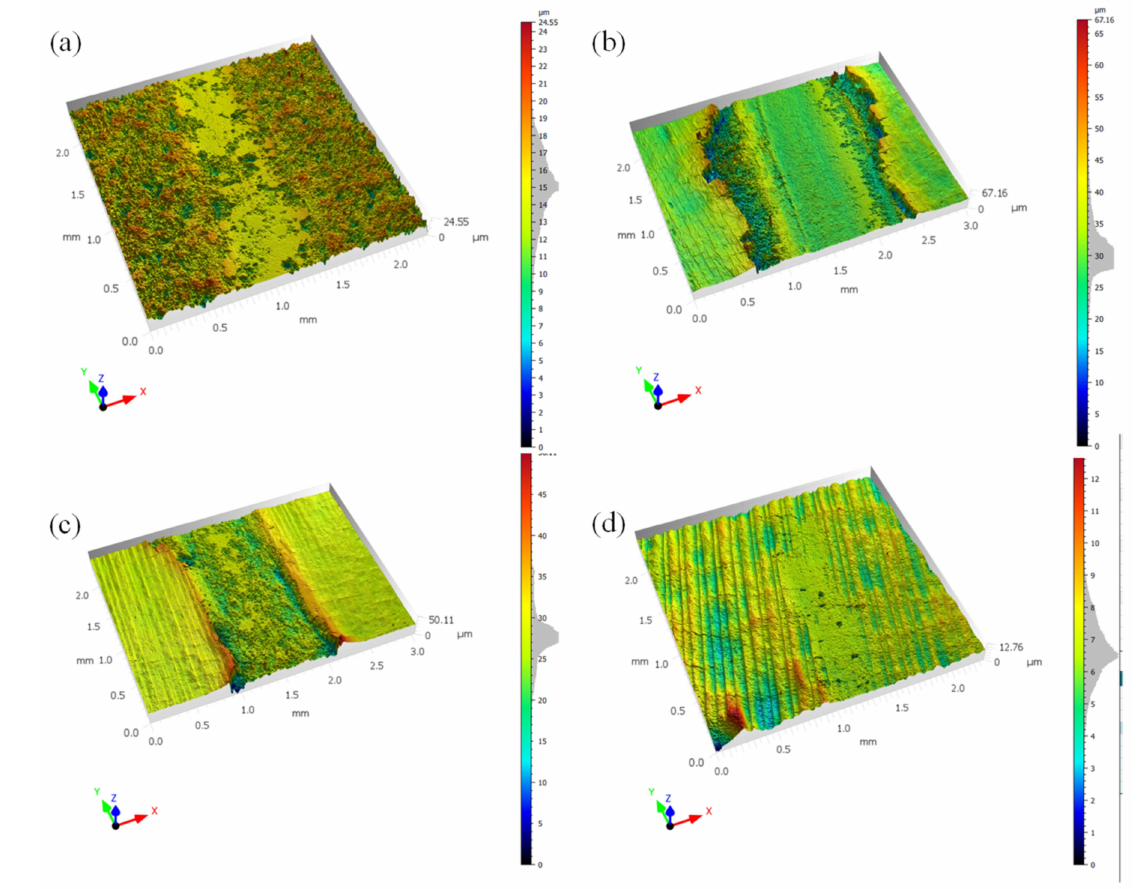
Figure 11. Friction wear track morphology. ( a ) 0#, original surface, ( b ) 1#, normal temperature, ( c ) 2#, preheating 450 ◦ C, ( d ) 3#, preheating 900 ◦